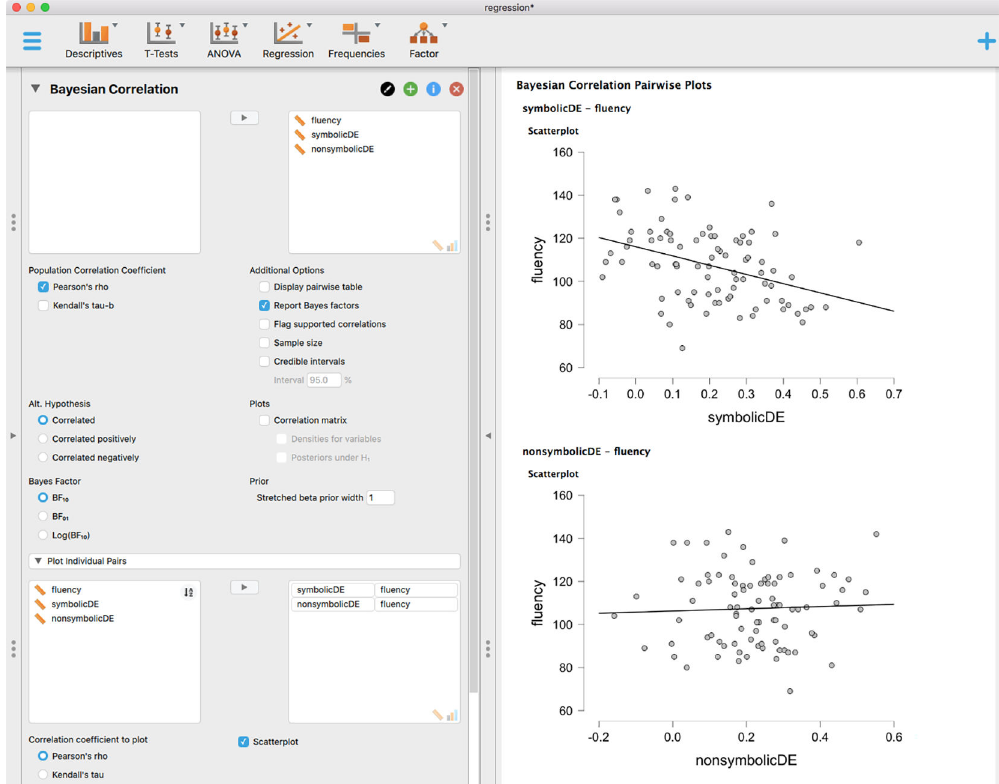
Figure 7. JASP screenshot showing how to construct scatterplots before performing a Bayesian linear regression.